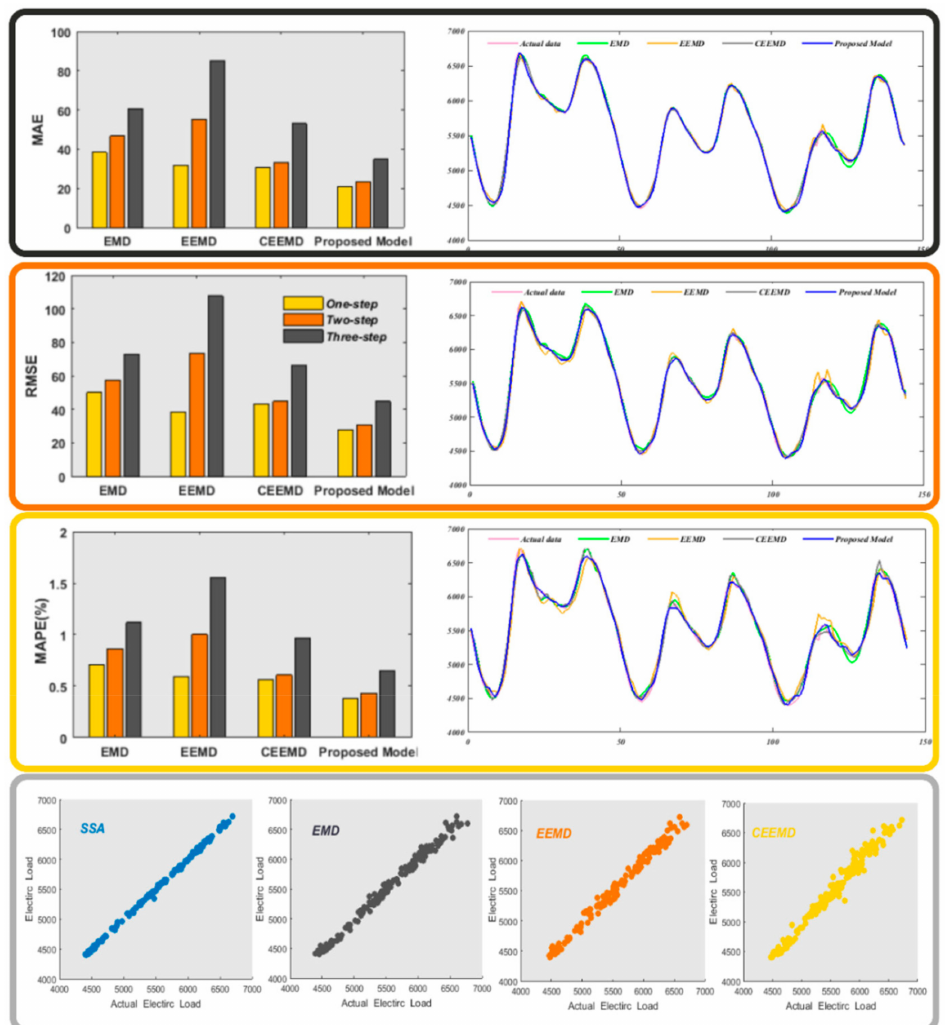
Figure 4. Comparison of multistep forecasting performance of Experiment II for QLD